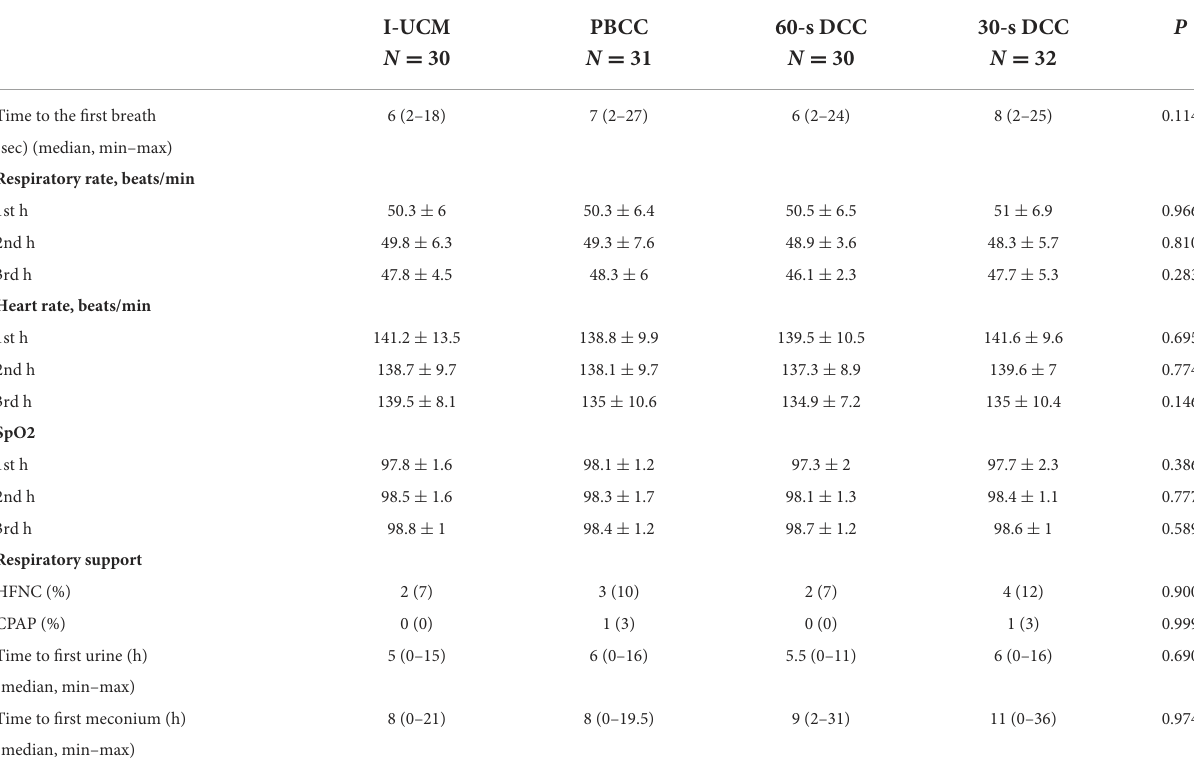
TABLE 4 Infants’clinical